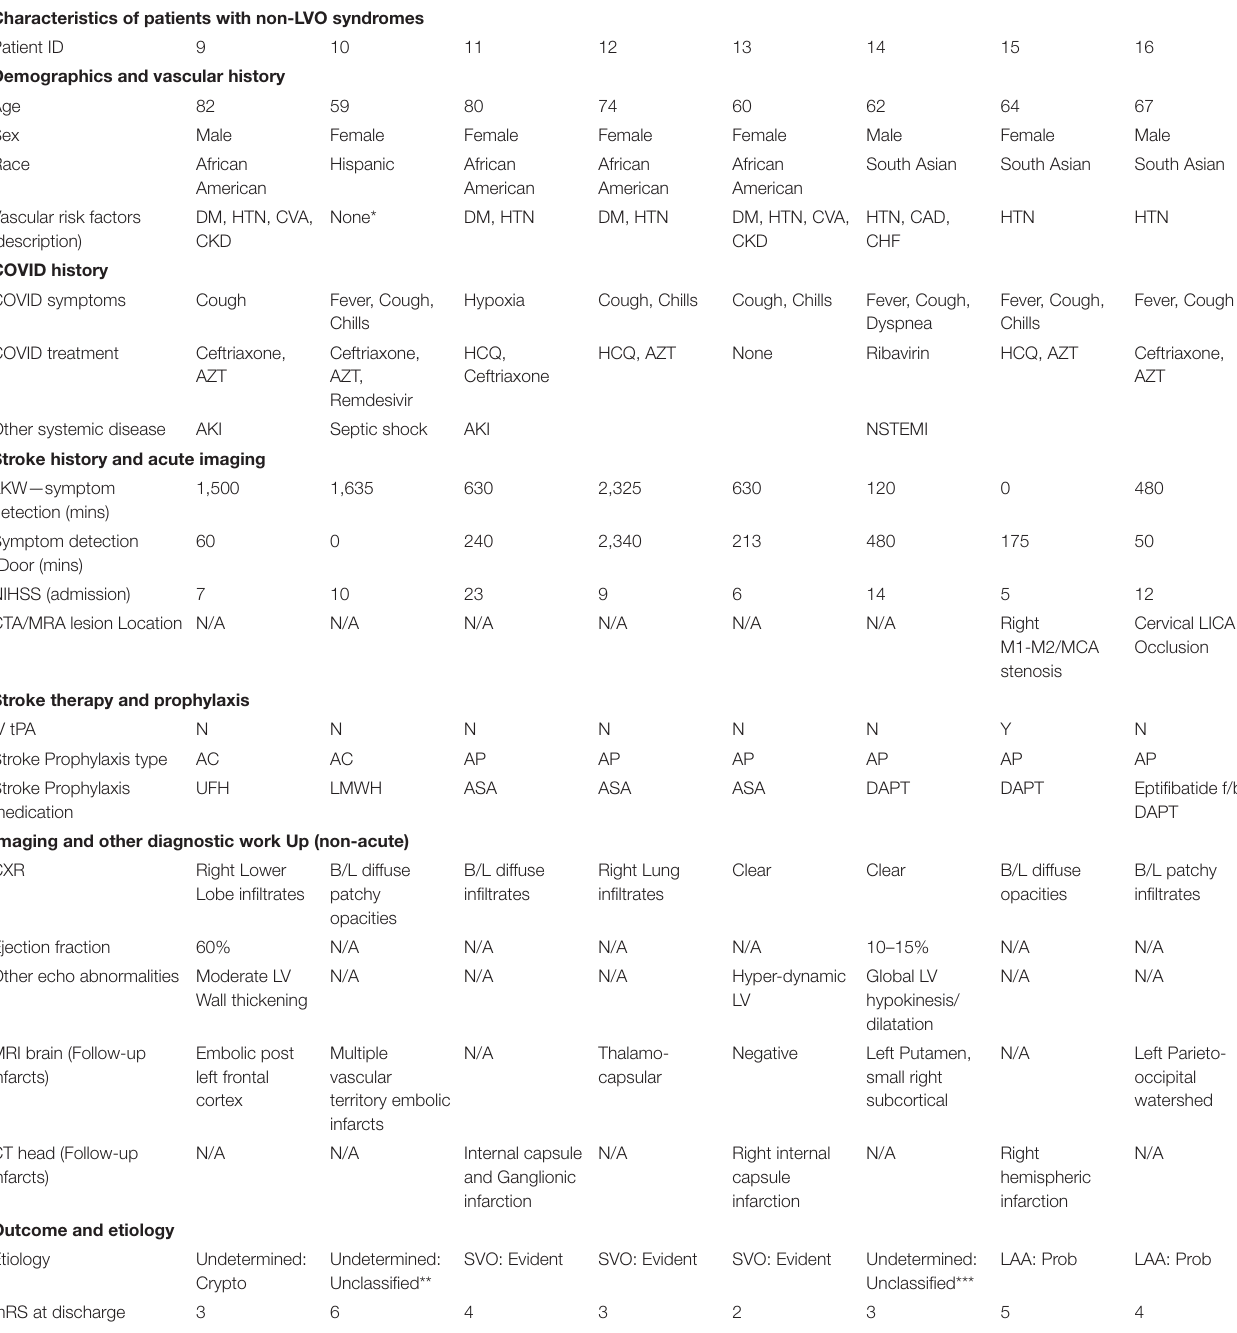
TABLE 2 | Patients with non large vessel occlusion (LVO) syndromes. Characteristics of patients with non-LVO